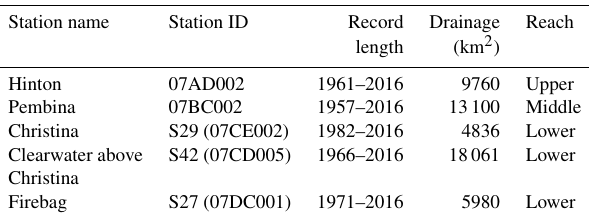
Table 2. Characteristics of hydrometric stations selected in this study.